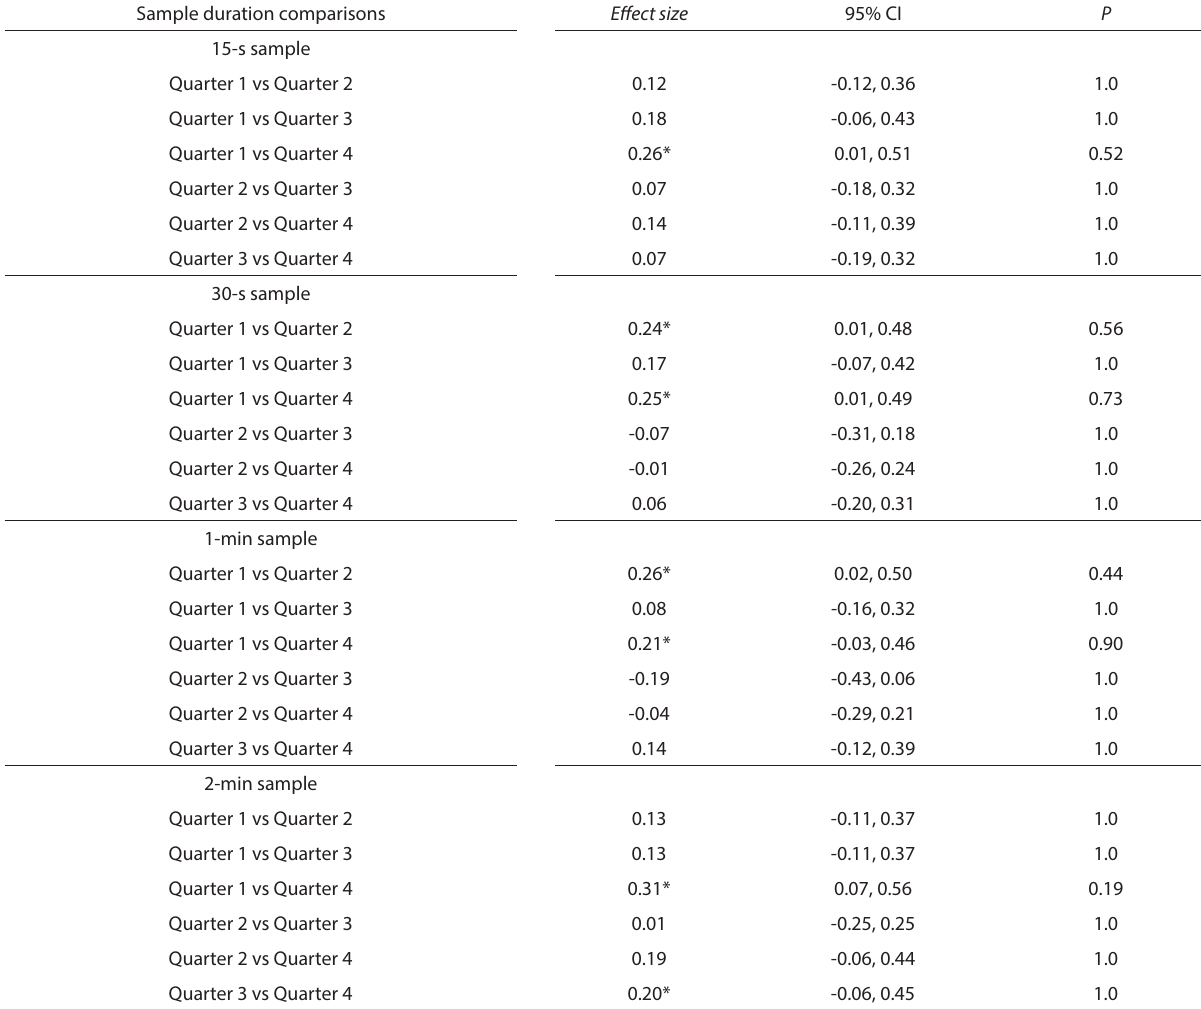
Table 1. Pairwise comparisons in peak PlayerLoad per minute between game quarters for each sample duration in semi- professional, male basketball